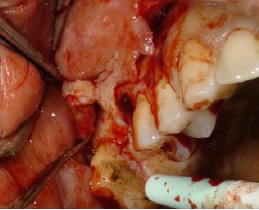
Figure 2. Detail of the design of the vestibular flap.